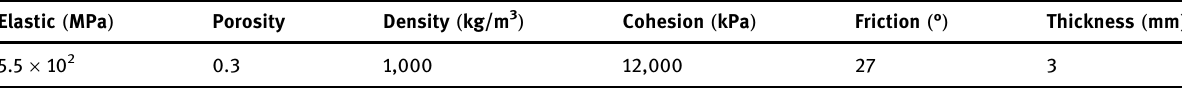
Table 1: Mechanical parameters of geocell